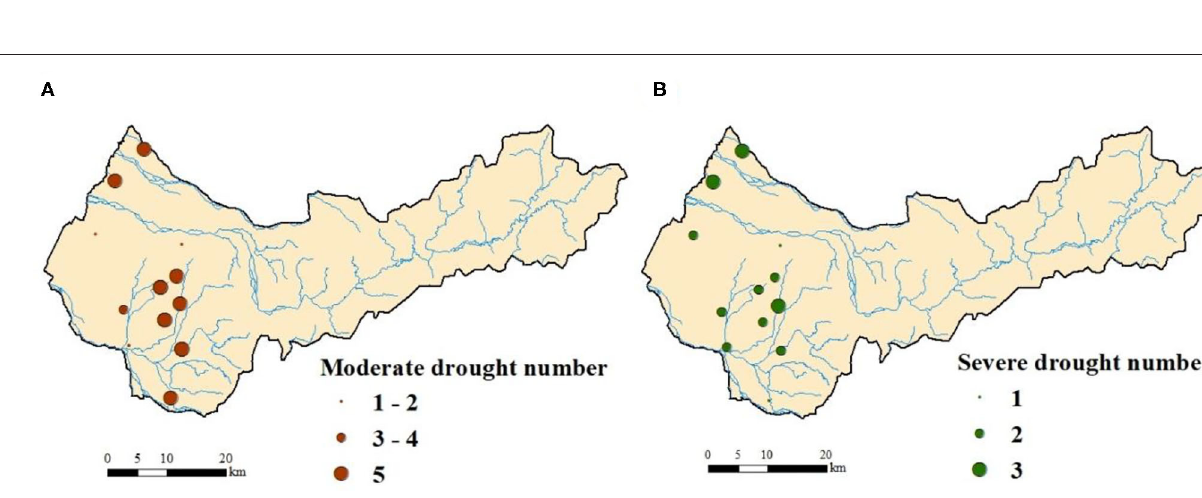
Frontiers in Water |